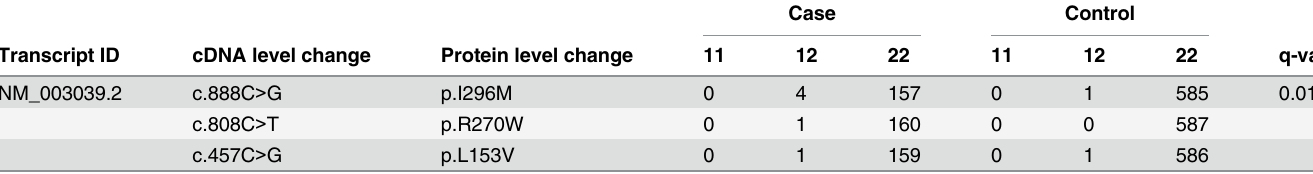
Table 4. Significant association of SLC2A5 detected by gene-based association study.